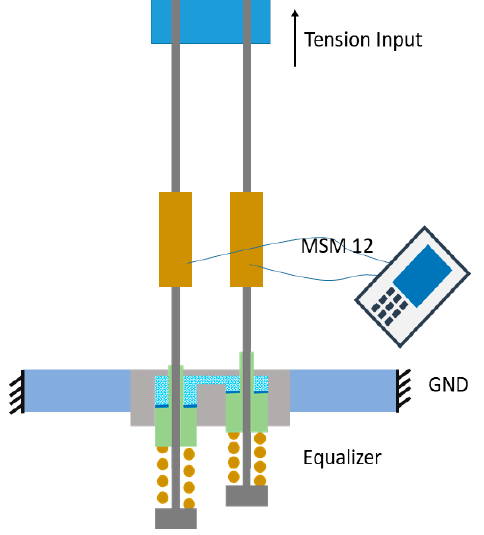
Figure 12. Schematic diagram of the performance test.